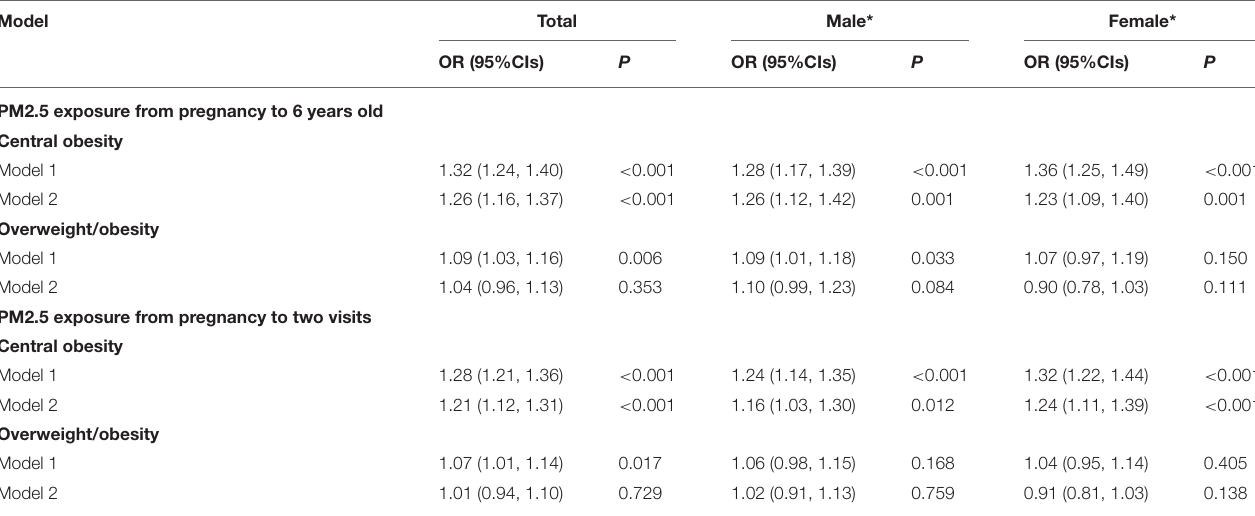
TABLE 3 | The effect of PM2.5 exposure (per 5 µ g/m3) on overweight/obesity and central obesity.